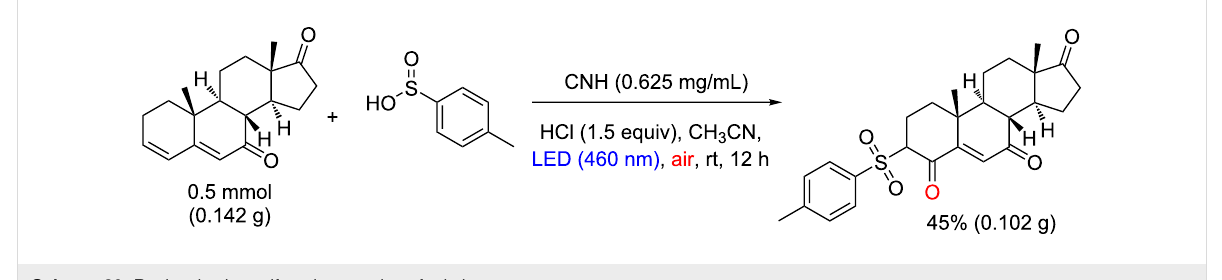
Scheme 20: Regioselective sulfonation reaction of arimistane.